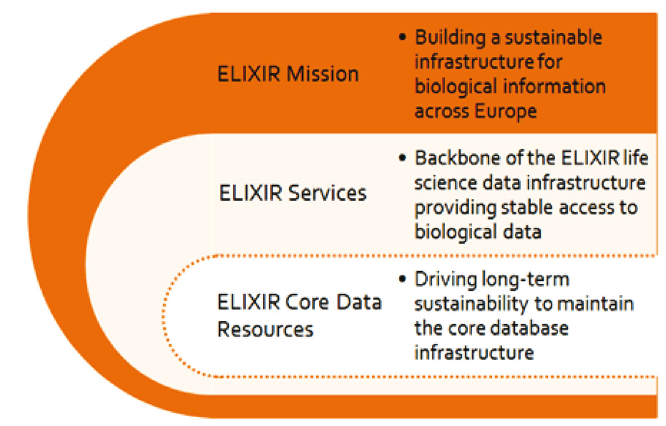
Figure 1. The place of ELIXIR Services and ELIXIR Core Data Resources within ELIXIR’s